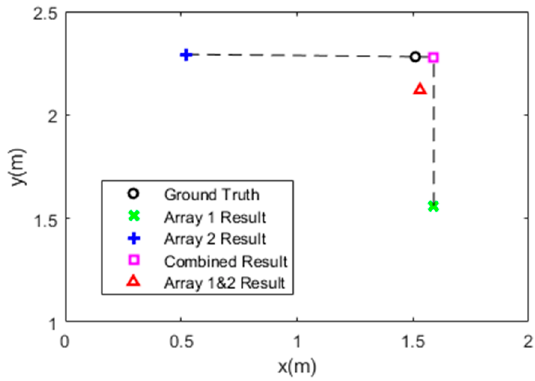
Figure 2. An example of using data from two arrays separately to improve localization result.